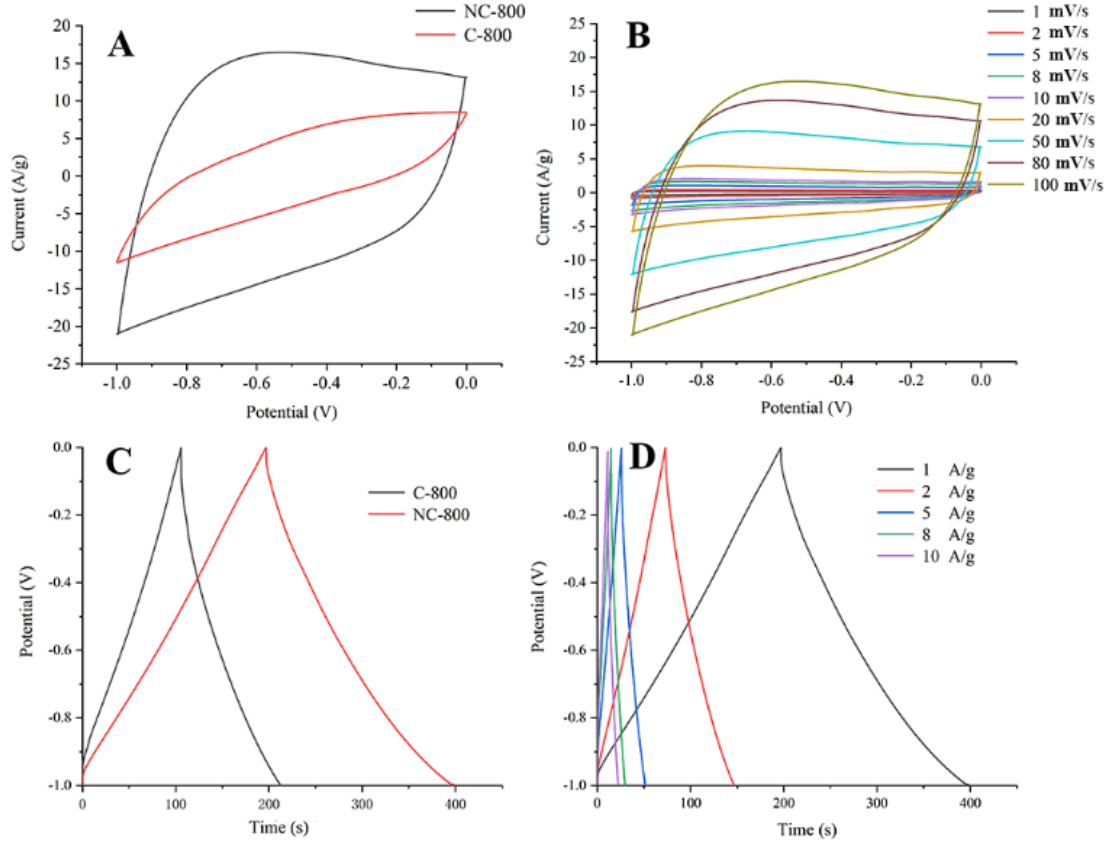
Figure 3. ( A ) CV curves of NC − 800 and C − 800 at 50 mV/s; ( B ) CV curves for NC − 800 at 1 − 100 mV/s; ( C ) GCD curves of NC-800 and C-800 at 1 A/g; ( D ) GCD curves of NC-800 at 1 − 10 A/g.